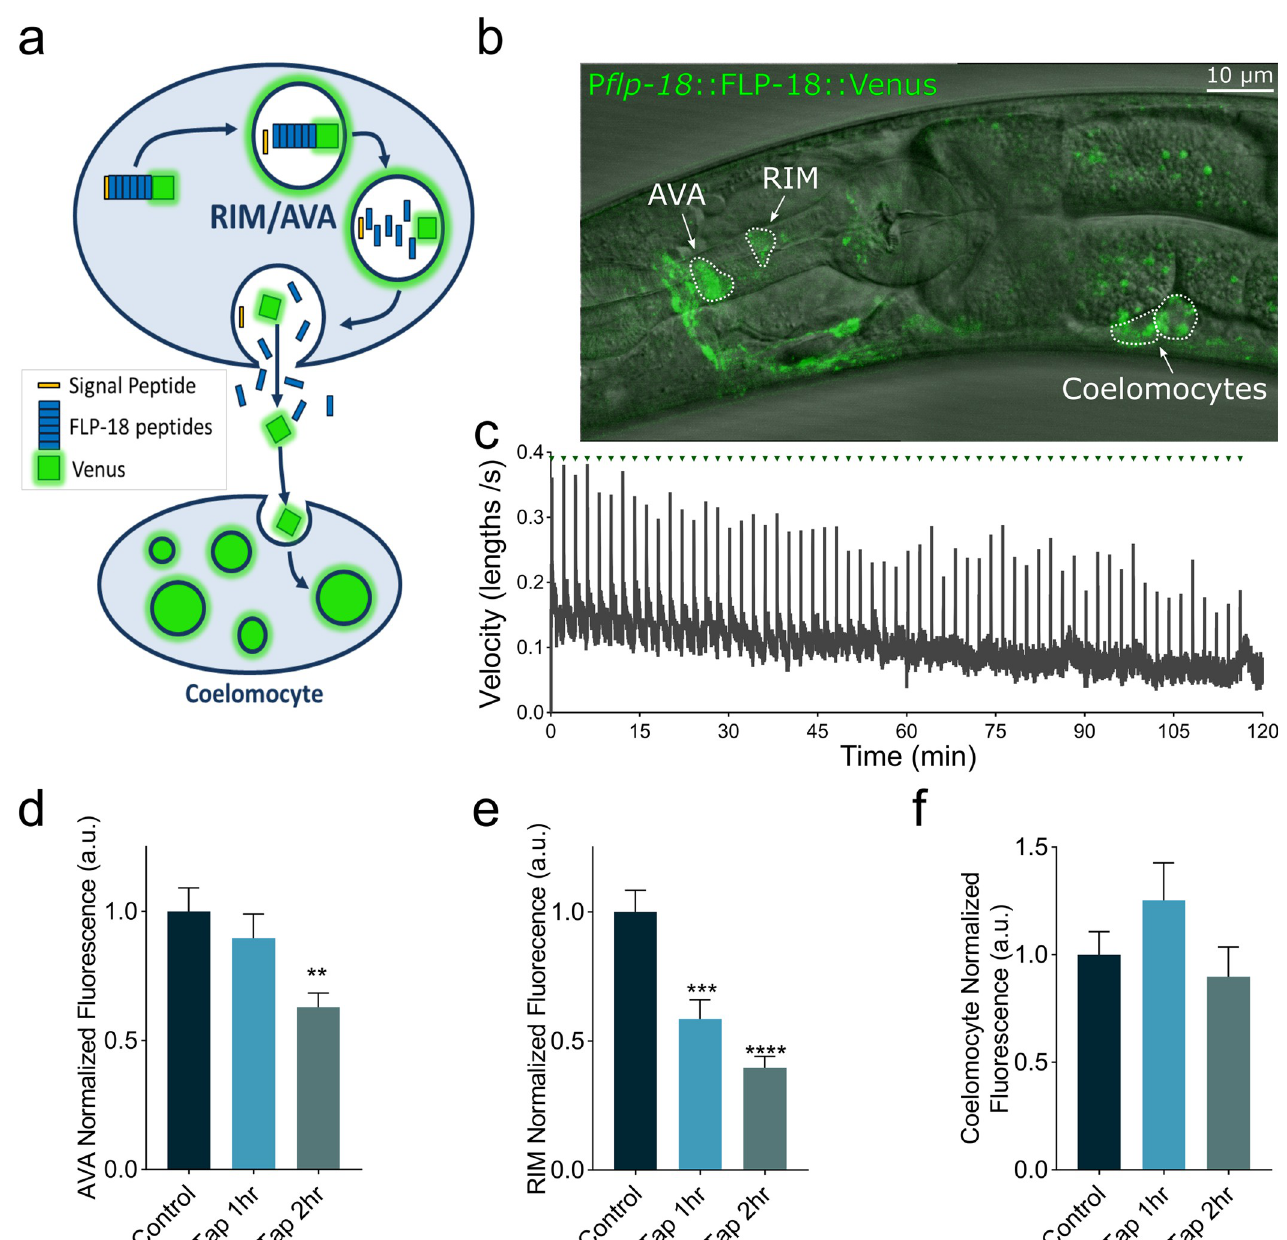
Fig 4. The escape response stimulates FLP-18 release from the AVA and RIM. Animals expressing a FLP-18::Venus fusion protein were subjected to repeated mechanical plate taps. The decrease in fluorescent intensity of the RIM and AVA cell bodies and the anterior-most coelomocyte were quantified as a readout of FLP-18 release. (A) Schematic illustrating the processing and exocytosis of the FLP-18::Venus fusion protein. (B) Representative image showing an animal expressing FLP-18::Venus, DIC and GFP overlay. Scale bar represents 10 μ m. (C) Average velocity of a population of animals as they are subjected to mechanical plate taps. Green arrows indicate the delivery of a tap every 2 min. The spikes in velocity coincide with the initiation of the escape response (D-E) Quantification of fluorescence (arbitrary units–a.u.) in the AVA (D), RIM (E), and coelomocytes (F), at 0-, 1- and 2-hour time points. Graphs represent mean ± SEM, significance was calculated using ANOVA with Dunnett’s multiple comparison test (P < 0.005 = �� , P < 0.0005 = ��� , P < 0.0001 = ���� ). Sample size: (C) n = 3 replicates, > 30 animals per replicate. (D-F) Control (n = 32), Tap 1 hr. (n = 26), Tap 2 hr. (n = 35).